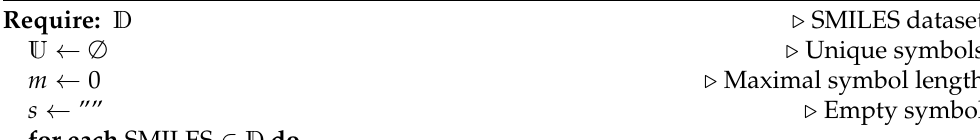
Algorithm 1 The algorithm for transformation of SMILES strings into SMILES